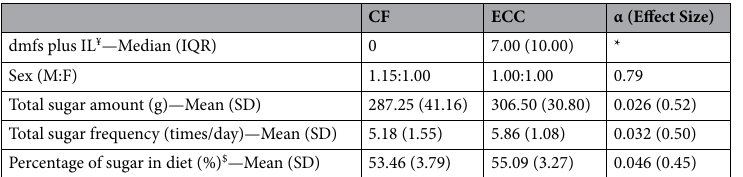
Table 1. Sample characteristics of volunteers. * Result not computed. Continuous outcomes were tested using an independent t-test for α and Hedges’ g for effect size. Sex distribution across the groups was tested using Chi-squared. ¥ The decomposed index was: 60% of WSL, 20% of active cavitated lesion, 11% of filled without decay, 7% of chronic cavitated lesion, and 2% of filled with chronic lesion. $ The calculation was based on the total sugar amount concerning all macronutrients from the diet. dmfs number of decayed, missing, or filled surfaces; ACL – active caries